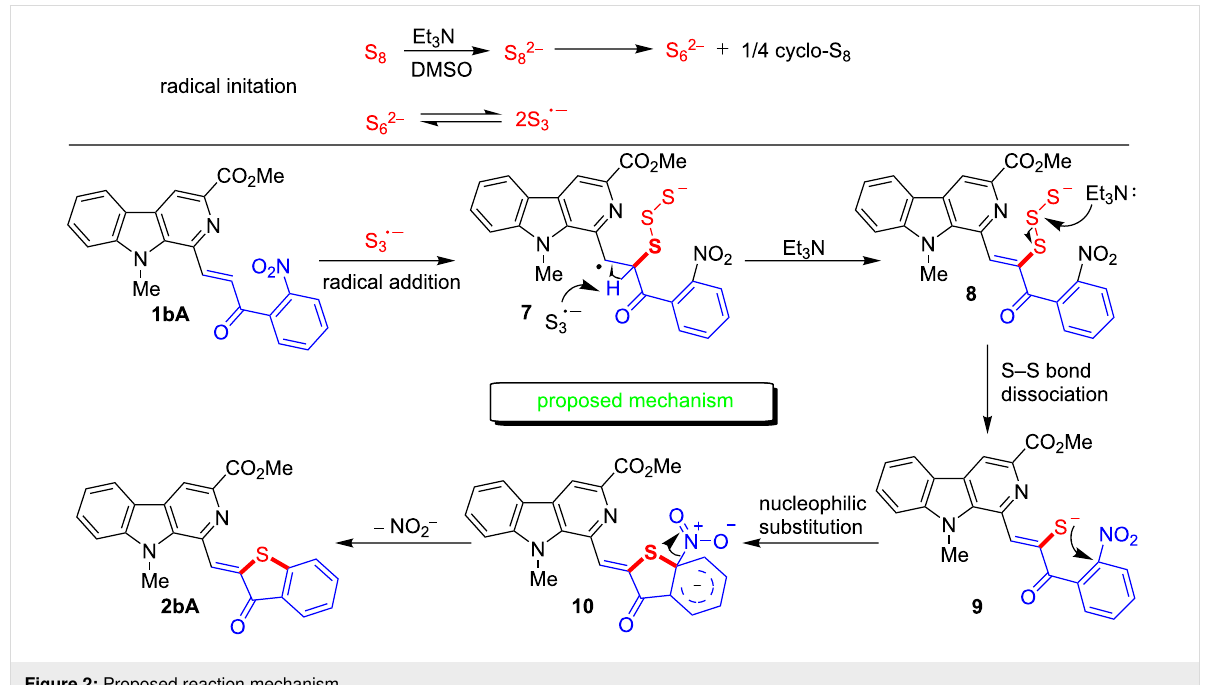
Figure 2: Proposed reaction mechanism.